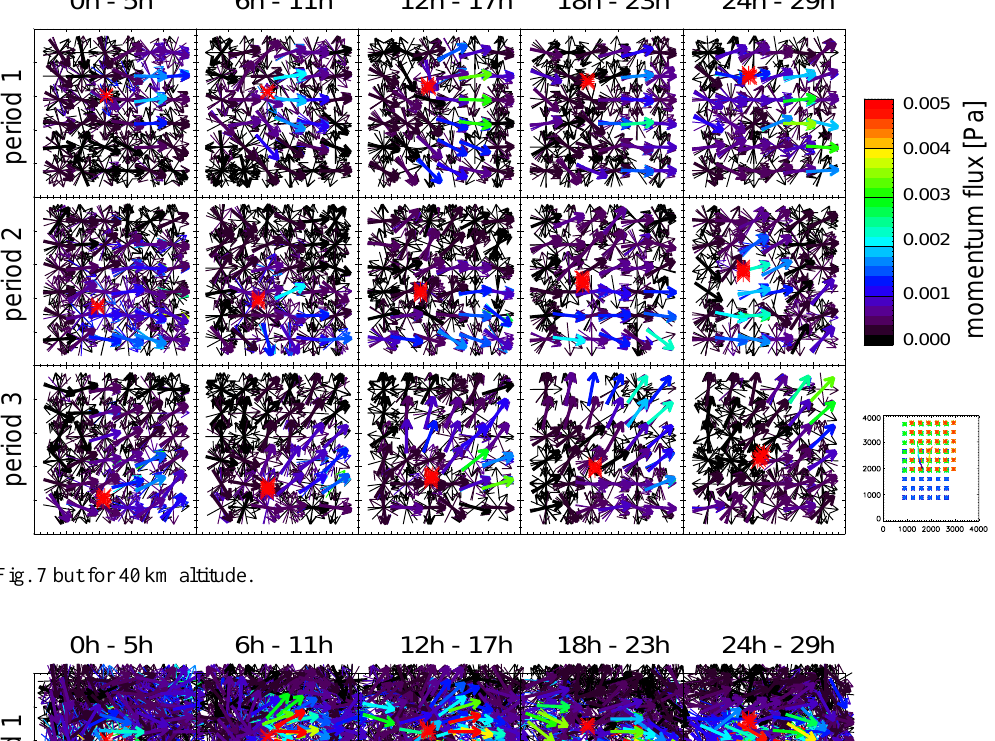
Fig. 8. As for Fig. 7 but for 40km altitude.